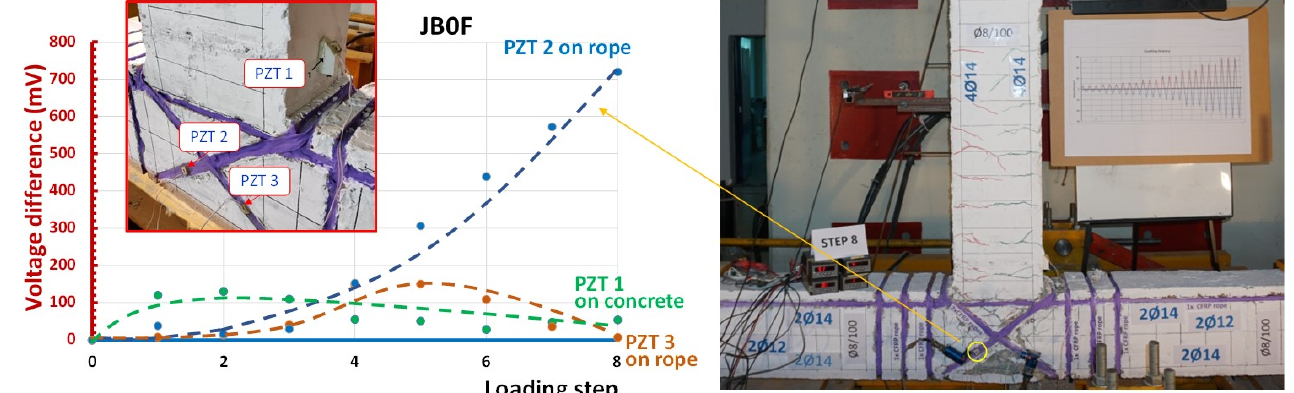
Figure 16. Voltage differences between the peak voltage value recorded at each loading step minus the voltage at the same frequency in the healthy condition represent the level of the damage that occurred in the vicinity of the PZT patch. The PZT 2 transducer attached to the C-FRP rope after the 5th loading step exhibited substantial increase in the voltage output indicating significant change/damage, as can be verified in the photograph of the cracking pattern of specimen JB0F after the imposed loading sequence. Concrete in the beam area near the joint remained more or less intact confirming the neglected voltage difference derived from the output of the PZT 1 transducer, which was epoxy-bonded on beam concrete surface.